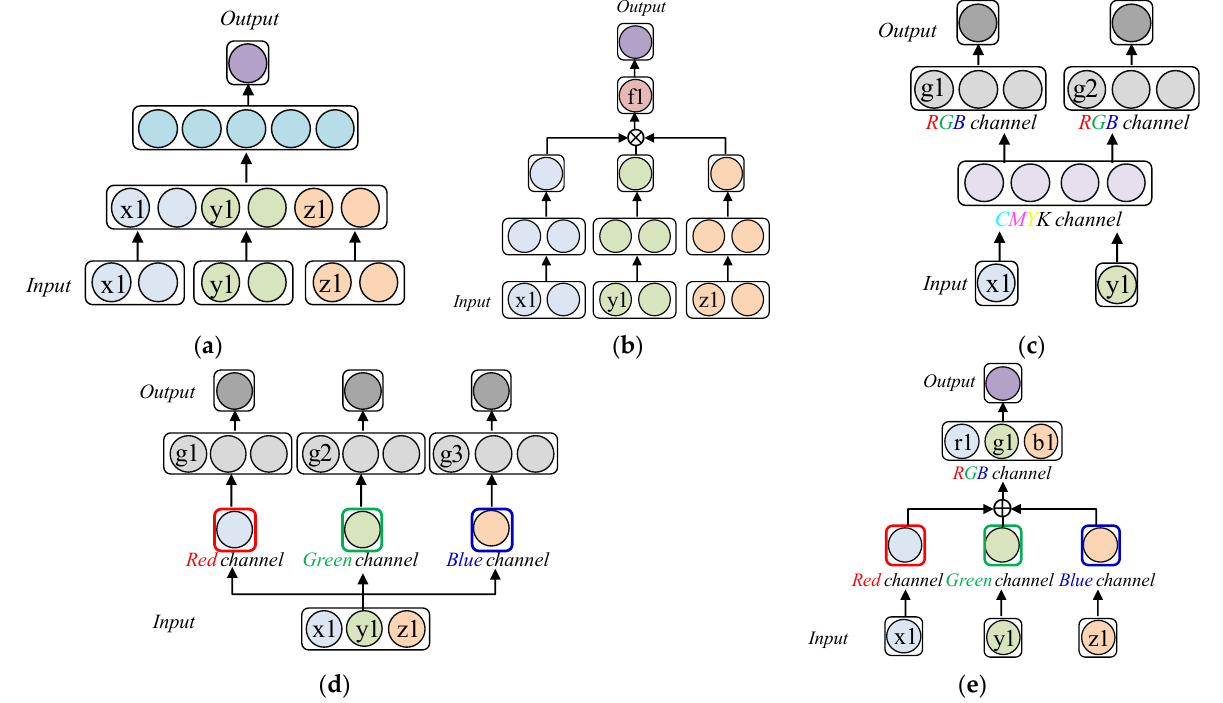
Figure 1. Three typical multi-modality fusion strategies. ( a ) Simple concatenation [11], ( b ) late fusion [12,13], ( c ) AV-TFN [14], ( d ) MTLN [16], and ( e ) the proposed method (TRT-Net).